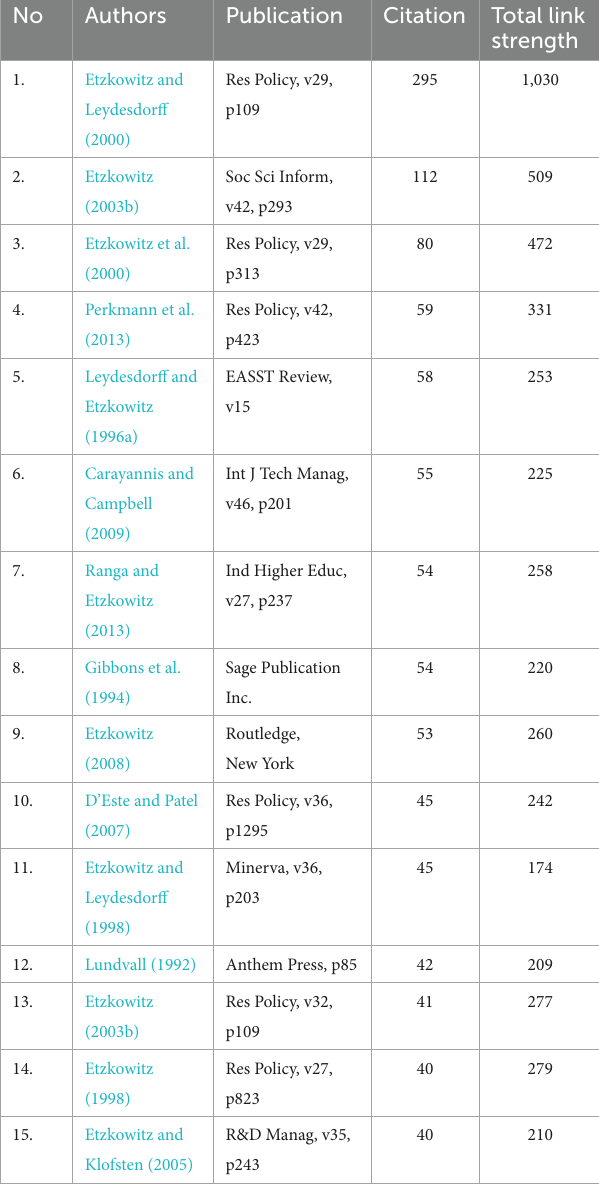
TABLE 2 Top 15 from 48 publication with the highest cited